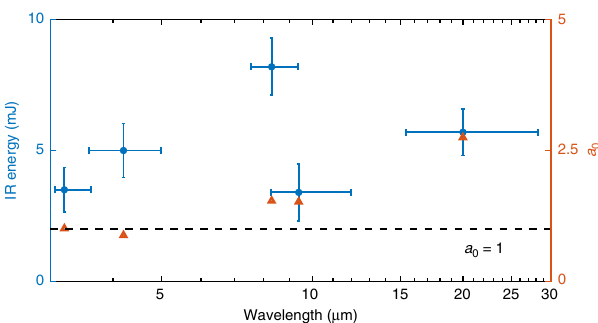
Fig. 3 Wavelength tunability. The data point with central wavelength of 9.4 μ m corresponds to that shown in Fig. 2 and the detailed XFROG data for other four cases are shown in Supplementary Figs. 11 – 14. The data points for IR energy are averaged over 240 shots. The wavelengths are shown on a logarithmic scale. The horizontal bars represent the wavelength ranges (FWHM) of the accumulated IR energy. The vertical bars represent the standard deviation of IR energy. The solid orange triangles correspond to the estimated normalized vector potential a 0 . The black dashed line marks the value of a 0 =